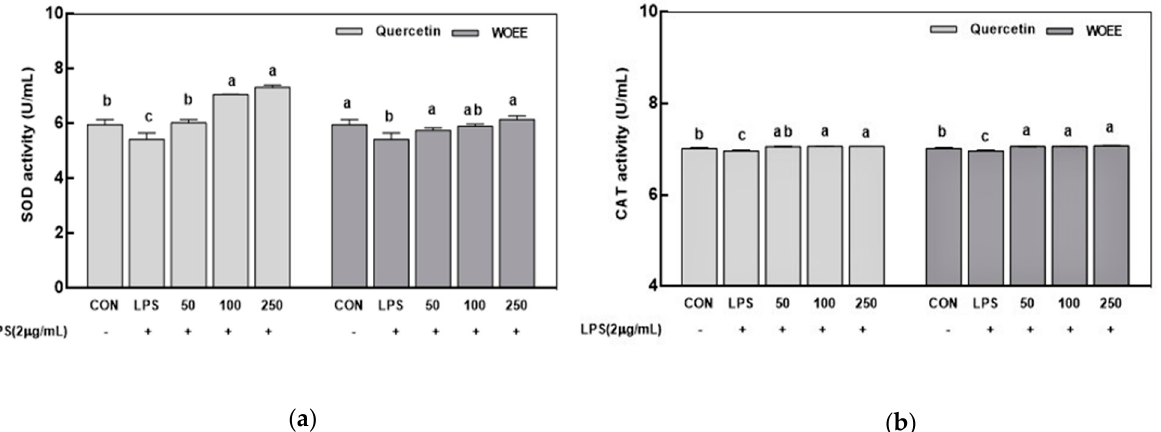
Figure 2. Antioxidant effects of quercetin and WOEE. ( a ) SOD and ( b ) CAT activities. The data were analyzed by one-way ANOVA using SPSS software and each bar presents the mean ± SE. (n = 3). a–c Mean values with different letters are significantly different ( p < 0.05) among groups, determined by Duncan’s multiple range